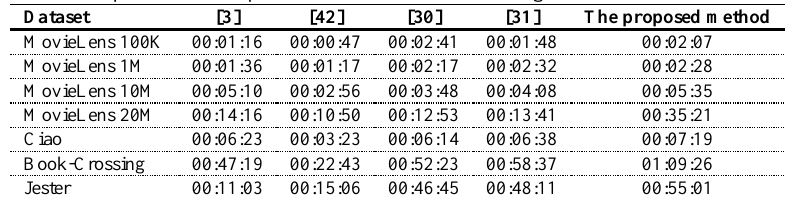
Table 7. Comparison of computational time. The results are given in the format hh:mm:ss .